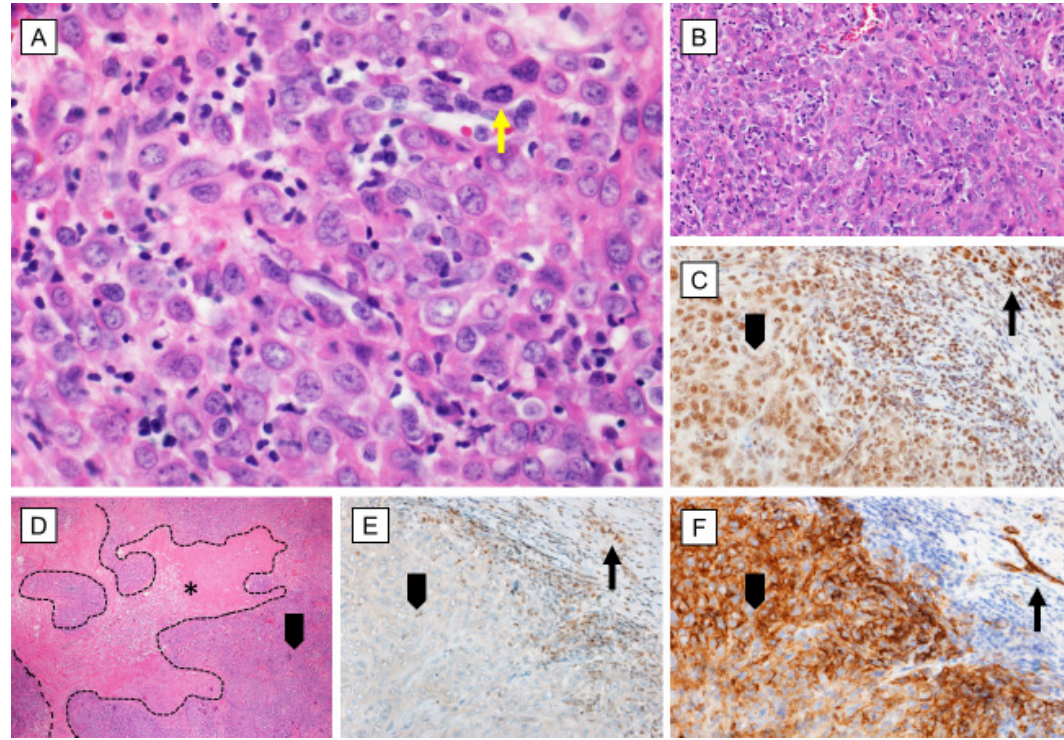
Figure 2. Epithelioid sarcoma—morphology and immune profile. ( A ), ( B ), ( D ) Epitheliod, large cells with abundant eosinophilic cytoplasm and moderate nuclear pleomorphism, mostly arranged in a solid sheath of neoplastic cells with marked geographical necrosis [hematoxylin-eosin 400×, 200× and 40× respectively]; ( C ) Positive strong nuclear reaction with FLI1 [200×]; ( E ) Immunohistochemical loss of INI–1 [200×]; ( F ) Positive strong reaction with CD34 [200×]; arrowhead—tumor cells; yellow arrow—mitotic figure; black arrow—internal control in endothelial cells; asterisk—necrosis. Immunohistochemically, ES cells present the features of mesenchymal and epithelioid cells. ES